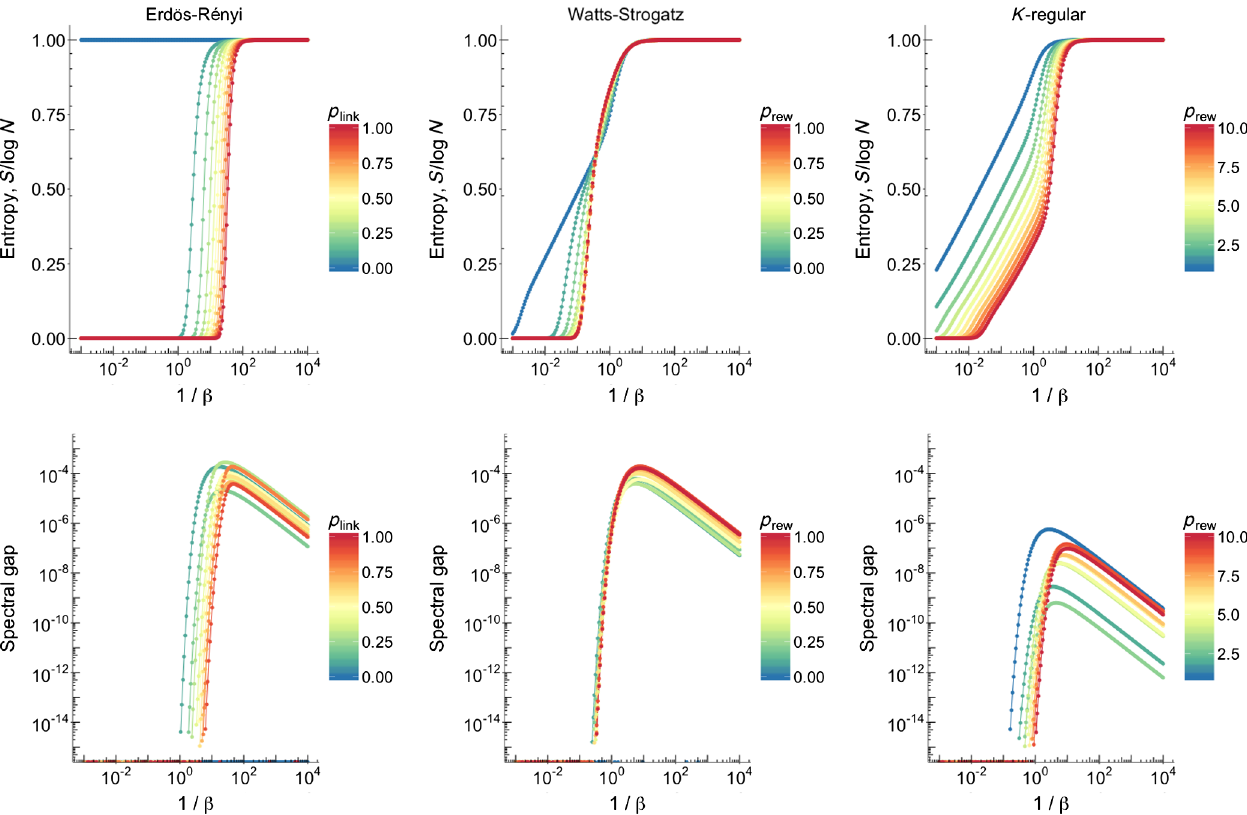
FIG. 2. von Neumann entropy of complex network models. Top panels: Spectral entropy as a function of 1 = β for Erdös-Rényi networks (left), Watts-Strogatz ’ s small-world networks (center), and K -regular lattices (right). Color encodes realizations obtained by varying the parameter of the network model, i.e., the probability p of a link between two nodes, the rewiring probability p , and the link rew number of neighbors K , respectively. In all cases, networks with N ¼ 200 are considered. Bottom panels: Spectral gap as a function of 1 = β . Note that the value of β where it is maximum corresponds to the value where a knee is observed in the spectral entropy (see Appendix B for further details).